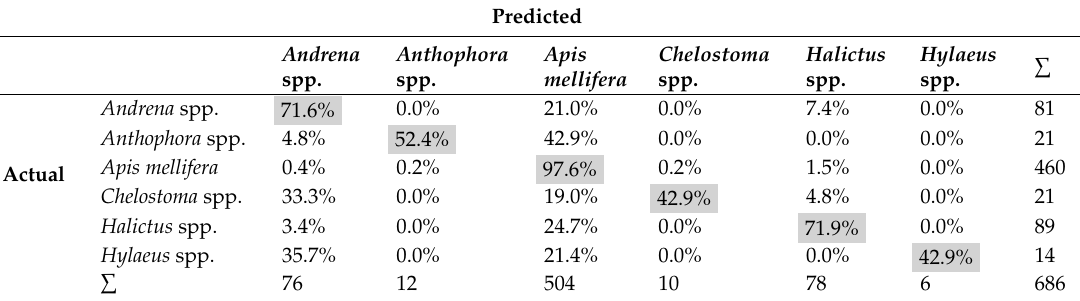
Table 1. Confusion matrices summarizing the percentages of visitors correctly identified by the random forest models (shaded diagonals), and the frequencies of misidentifications. Table 1 summarizes a model that included five shape-related and two phenology-related explanatory variables.